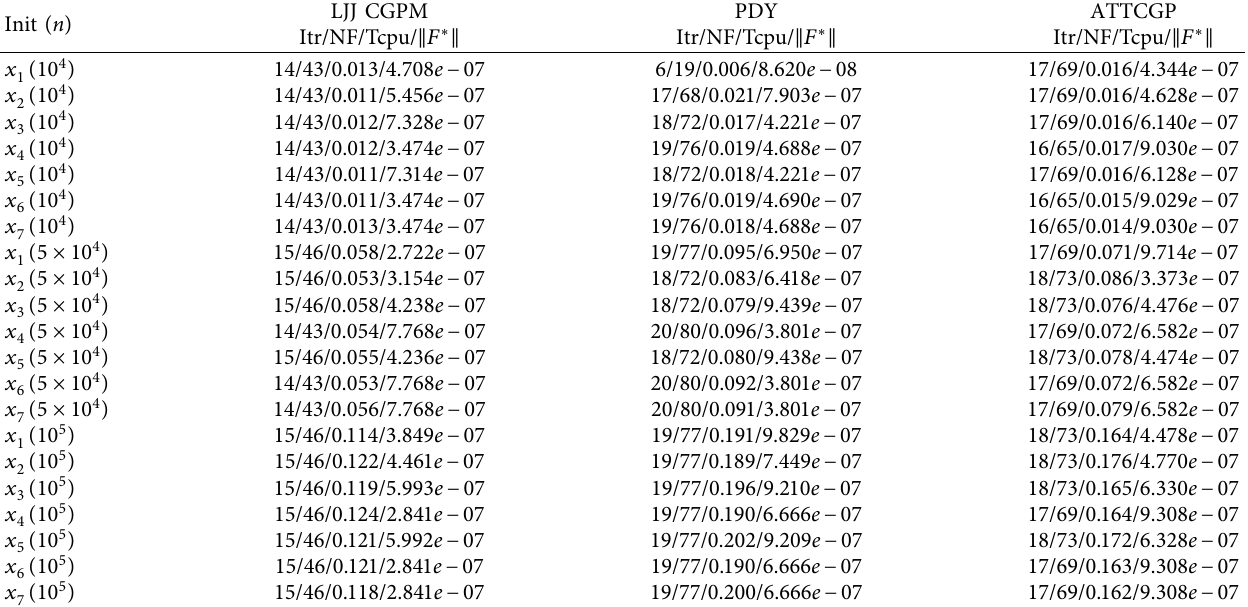
Table 3: Numerical results on Problem 3.